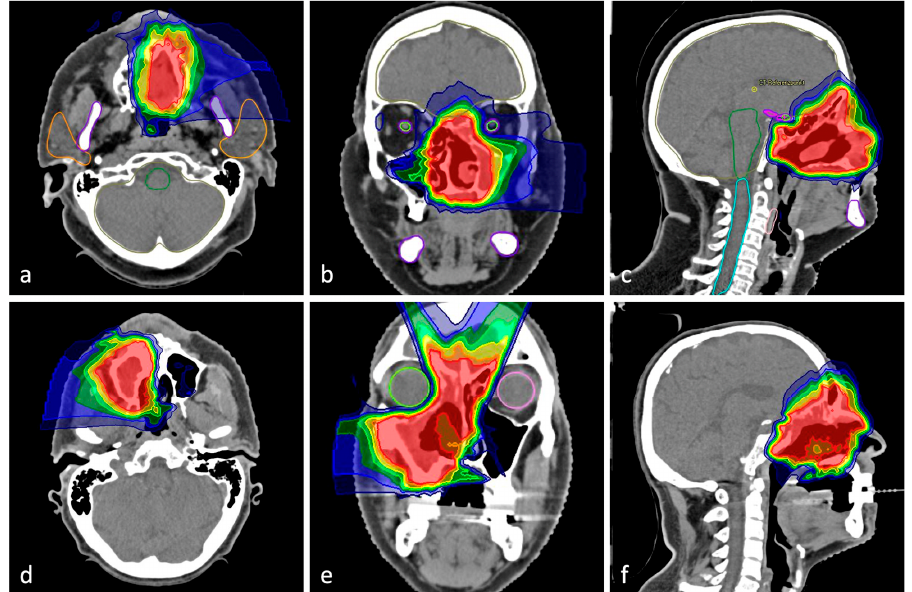
Figure 1. Sectional images of an exemplary patient from the control group ( a – c ); melanoma of the nasal cavity) and from the intervention group ( d – f ); sinonasal undi ff erentiated carcinoma). When comparing the radiation treatment plans in coronal and sagi tt al sections, it can be observed how tissue retraction results in a signi fi cant dose reduction in the area of the tongue. Red color indicates areas with a high radiation dose, blue color those with a lower dose. Participants in the control group received an active control consisting of soft, fl exible dental splints with a layer thickness of 5 mm for the maxilla and mandible. These splints are the standard treatment for patients with radiotherapy of head and neck cancer accord- ing to NCCN guidelines [25]. Their rationale is based on studies describing a backsca tt er e ff ect of dental materials. The shielding achieved by the splints is meant to protect the adjacent soft tissue [26,27]. For this purpose, alginate impressions of the maxilla and mandible were taken, and the splints were fabricated (material: Erkoflex 5 mm, Erkodent, Pfalzgrafenweiler, Germany; thermoforming device: Erkoform RVE, Erkodent, Figure 2) by thermoforming on gypsum casts.